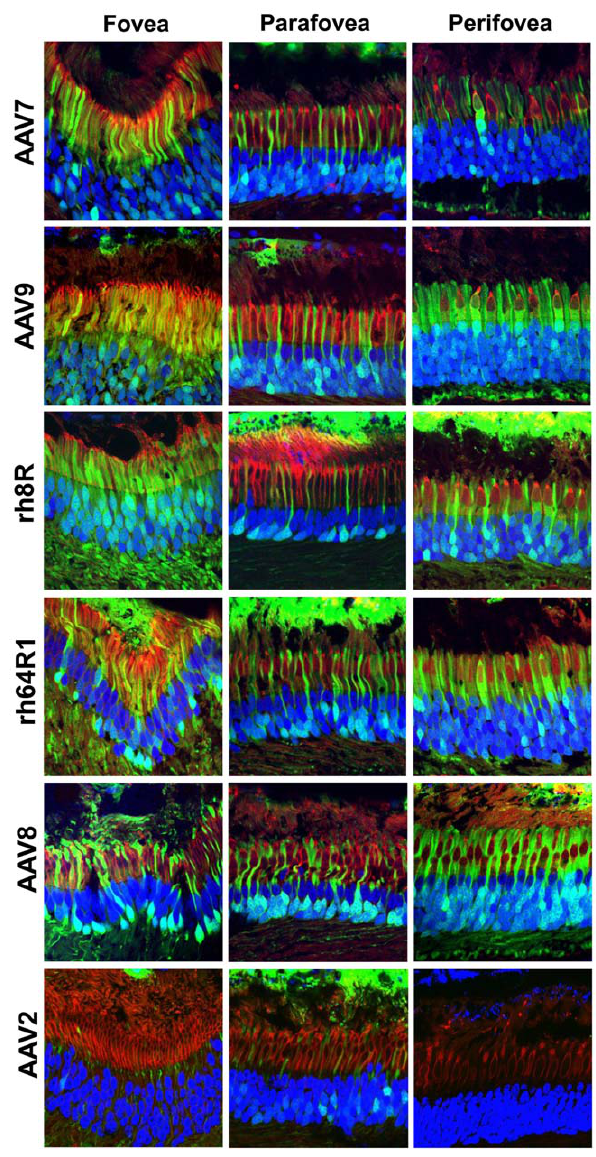
Figure 2. AAV cell targeting in the fovea, parafovea and perifovea. Histological sections were stained with DAPI (blue) and peanut agglutinin (red), a lectin specific for terminal galactose residues prevalent on cone PR, and finally visualized for GFP (green) by direct fluorescence. The foveal, parafoveal and perifoveal regions were identified based on topology and cone density. Perifoveal areas were chosen in a region between 1.3 and 1.9 mm from the fovea. Within the subretinal injection area, cone transduction in the peripheral retina was similar in efficiency to that in the perifovea.